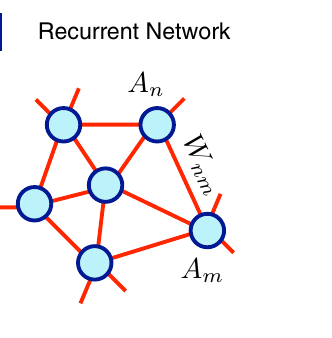
Figure 1. Neurons with different network structures: ( A ) Recurrent neuronal network often observed in biological nerve systems. ( B ) Feed forward network with input, output and hidden layers, largely put to practice in deep